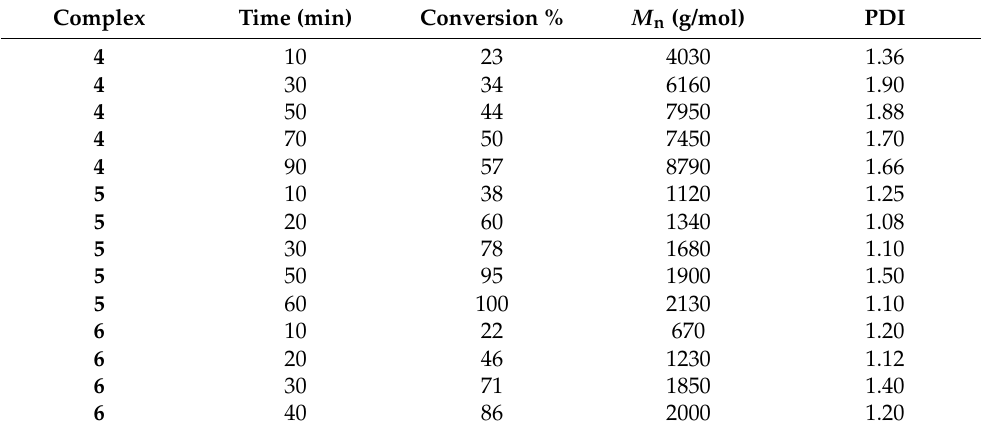
Polymerization conditions: 5 mL of toluene, r.t, 11 µ mol of catalyst. Cat: ε -caprolactone; 1:100. The conversion was determined by 1 H NMR spectroscopy of the crude reaction. The M n values were relatively